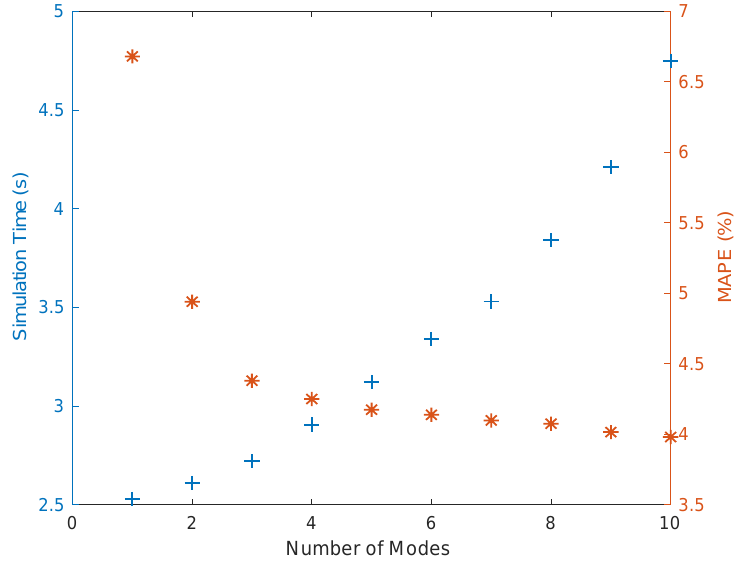
Figure 8. Simulation time vs. mean absolute percent error (MAPE).